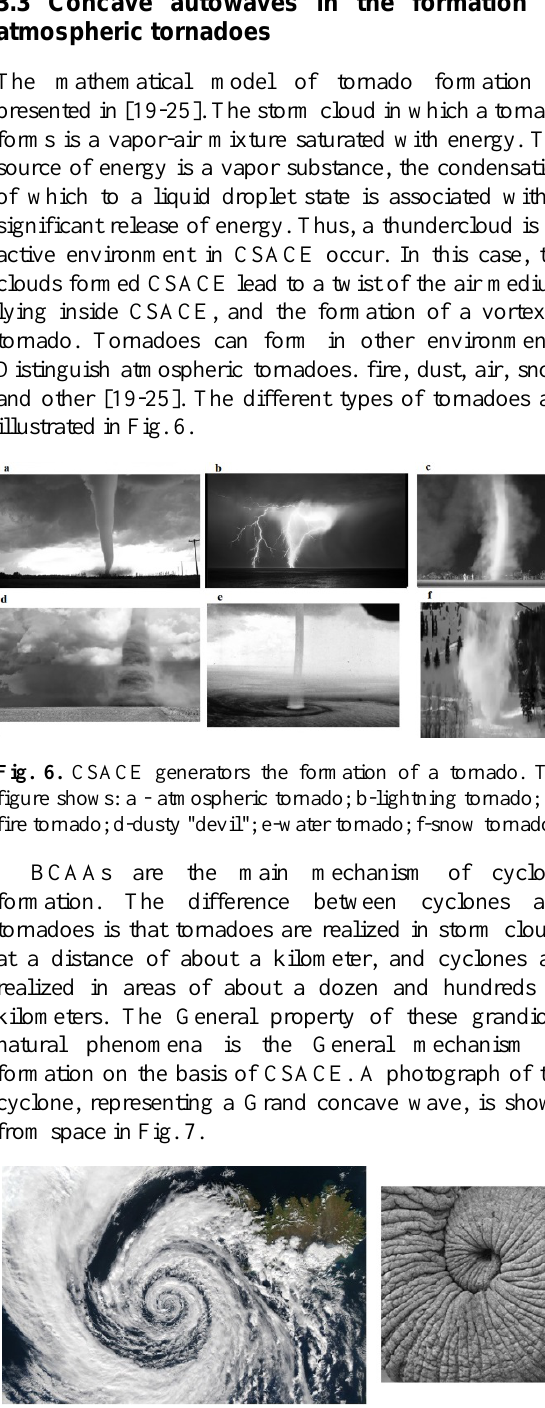
Fig. 7. Photo of the cyclone from space. Pay attention to the similarity of the shape of the cyclone with the shape of the folded trunk of the elephant, shown on the right.